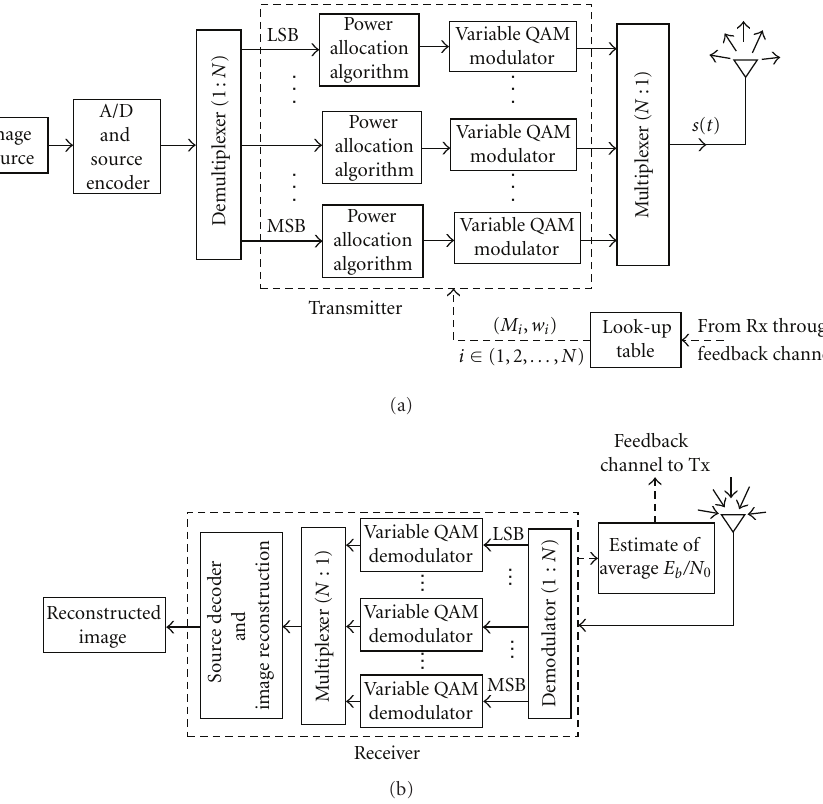
Figure 1: Block diagram of proposed image transmission